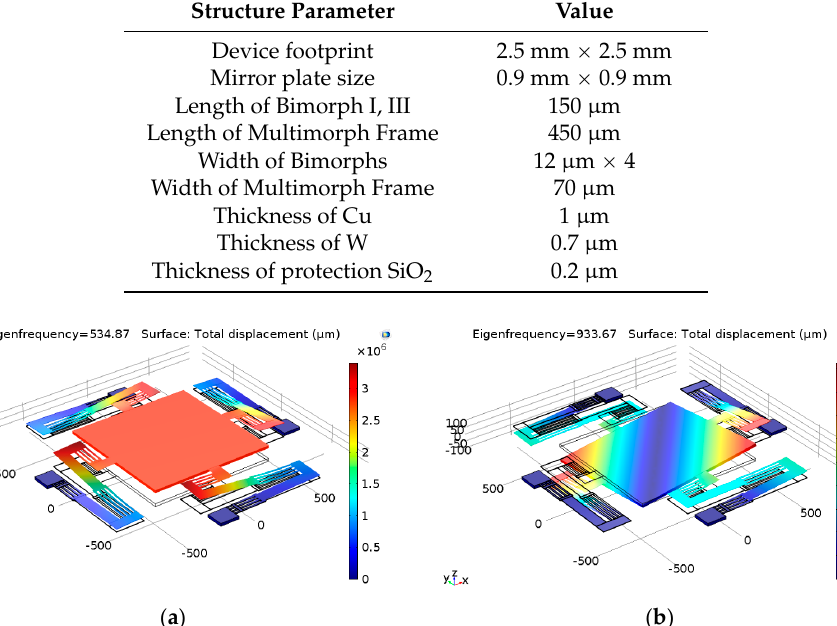
Table 2. Design parameters of the Cu/W LSF MEMS mirror.